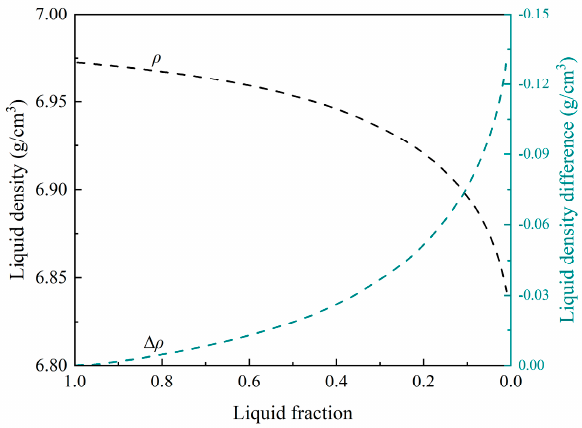
Figure 6. Variation of liquid density and density difference during solidification.